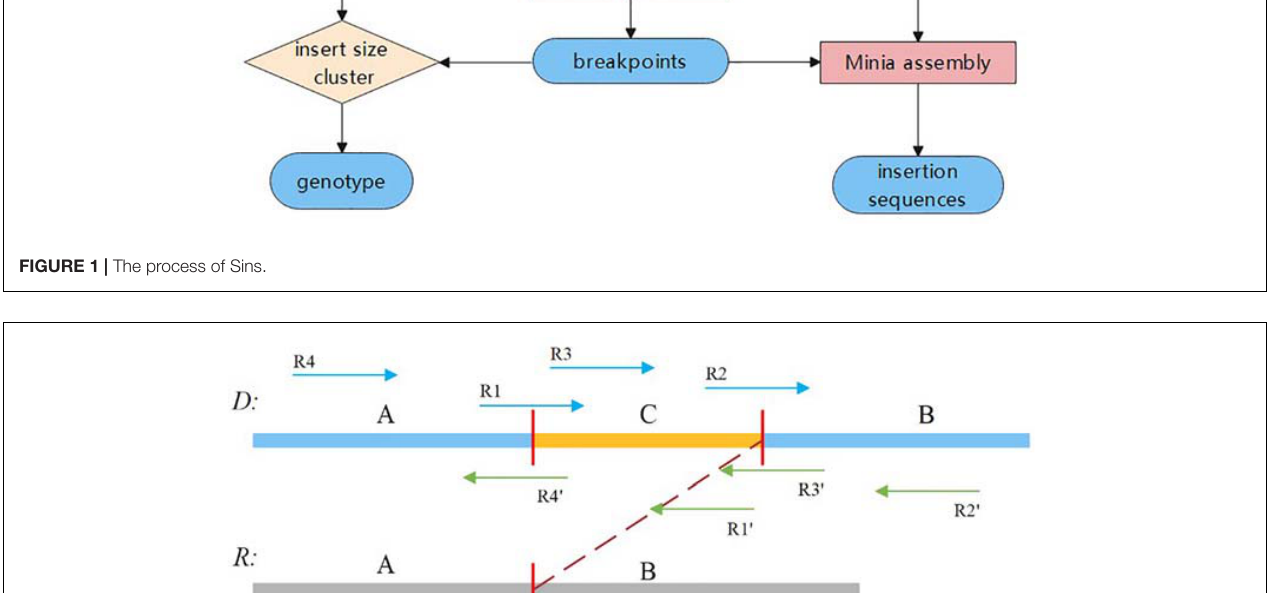
FIGURE 2 | Sequence A and B is normal, and sequence C is insertion sequence. R1, R2, R4 (cid:48) ,and R3 (cid:48) are soft-clipped reads. R1 belongs to the LL type, R2 belongs to the LR type, R4 (cid:48) belongs to the RL type, and R3 (cid:48) belongs to the RR